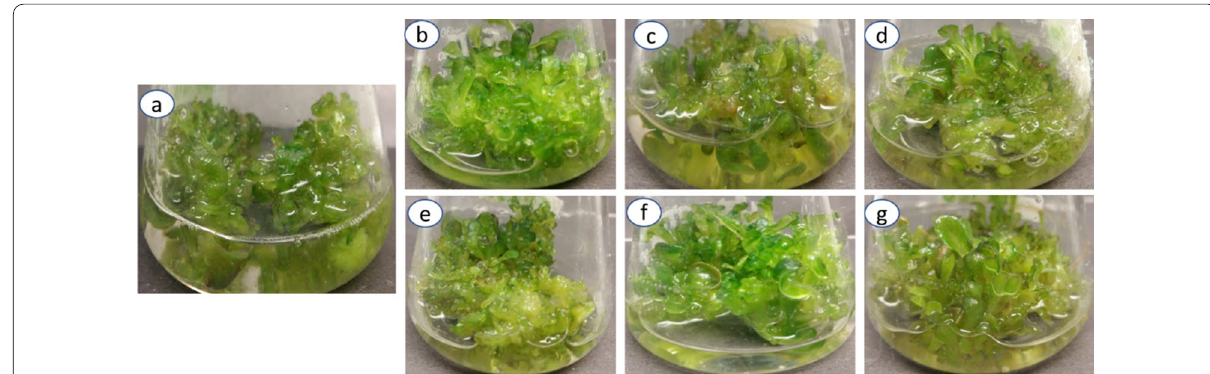
Fig. 2 Morphology of Ajuga integrifolia agitated micro‑shoot cultures, a control, b YE 1.0 mg/L, c YE 10 mg/L, d YE 200 mg/L, e PE 1.0 m/L, f PE 10 mg/L, g PE 200